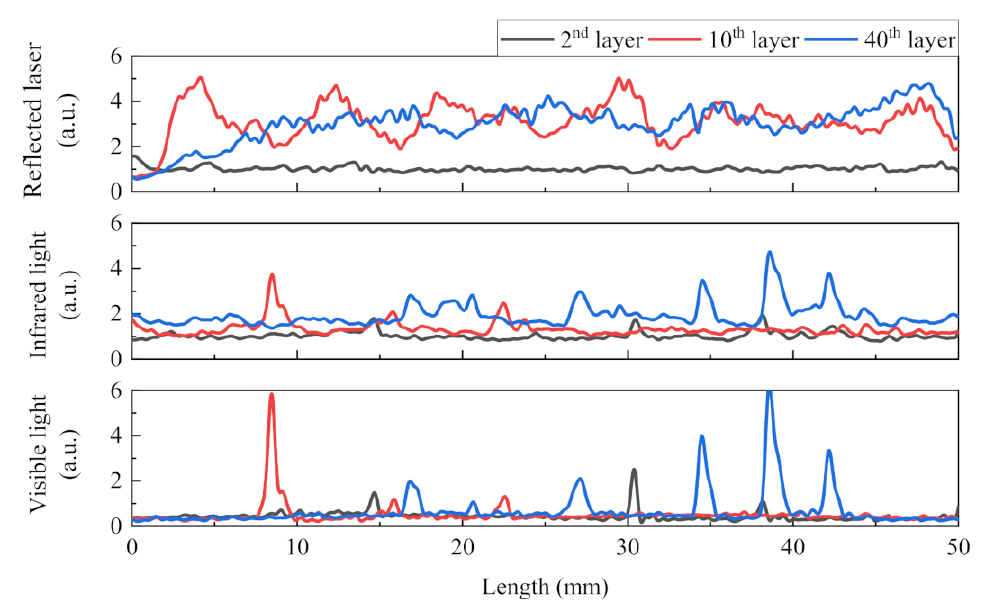
Figure 7. Filtered signals from different layers during LMD process with laser power 900 W.